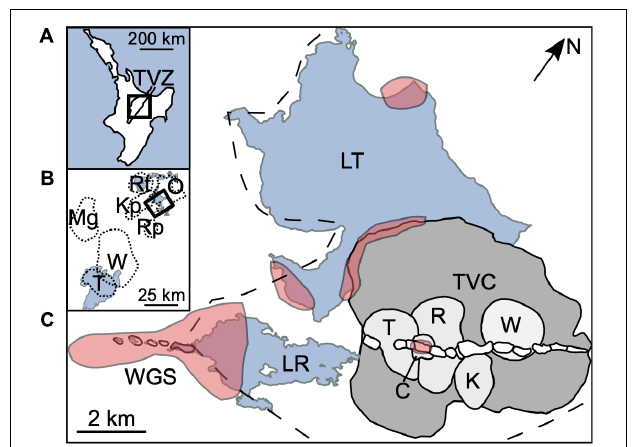
FIGURE 1 | (A) North island of New Zealand with the location of the Taup¯o Volcanic Zone (TVZ), where the black square shows the area covered in (B) caldera systems (black, dotted lines: Rt = Rotorua, O = Okataina, Kp = Kapenga, Rp = Reporoa, Mg = Mangakino, W = Whakamaru, and T = Taup¯o) and lakes (blue) within the Taup¯o Volcanic Zone, where the black square shows the area covered in (C) Waimangu Geothermal System (WGS), Lake Rotomahana (LR), and Tarawera Volcanic Complex (TVC, dark gray with black, solid outline), including the recent domes (light gray with black, solid outline: T = Tarawera, C = Crater, R = Ruawahia, K = Kanakana, and W = Wahanga) and 1886 fissure (white with black, solid outline), where lakes are in blue (LT = Lake Tarawera), red regions are areas of geothermal activity from Nairn (2002), and the black, dashed line indicates the Okataina caldera